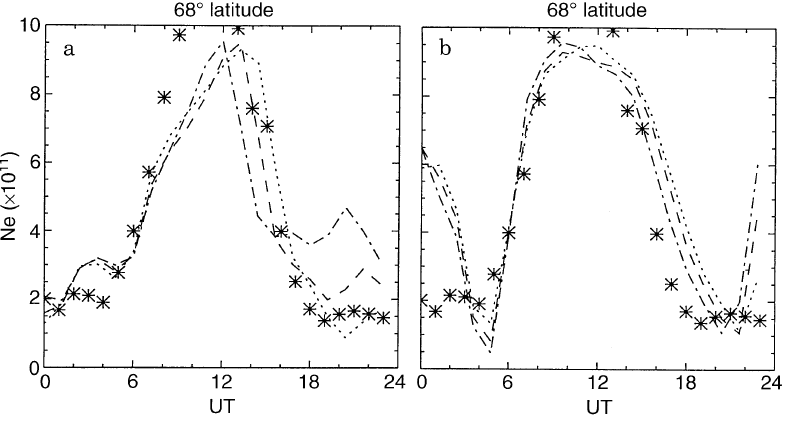
Fig. 10a, b. Measured ( asterisks ) and modelled ( lines ) electron densities at 300 km and 68 ° N. a RUN-1, and b RUN-3. The lines are the same as Fig.